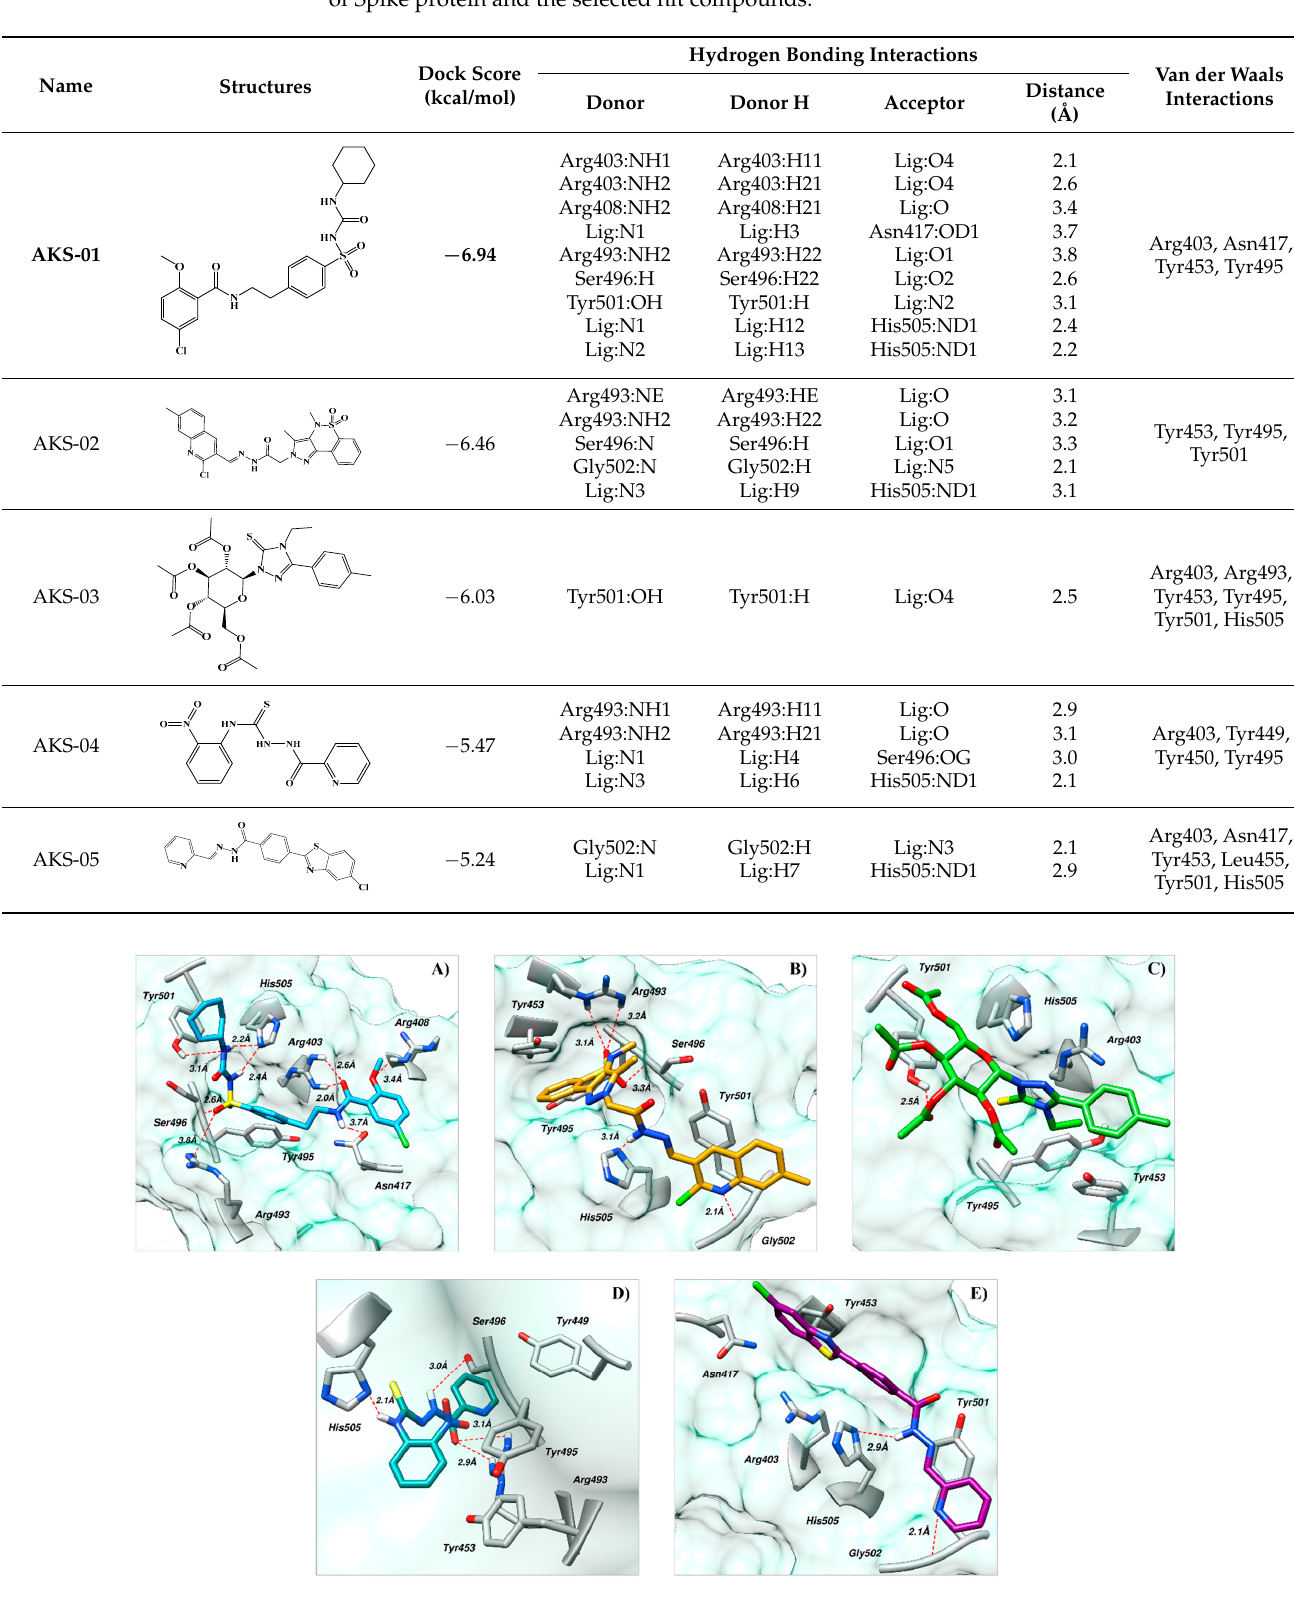
Figure 1. Docked poses of selected five compounds in the binding site of RBD. ( A ) AKS-01, ( B ) AKS- 02, ( C ) AKS-03, ( D ) AKS-04, and ( E ) AKS-05.